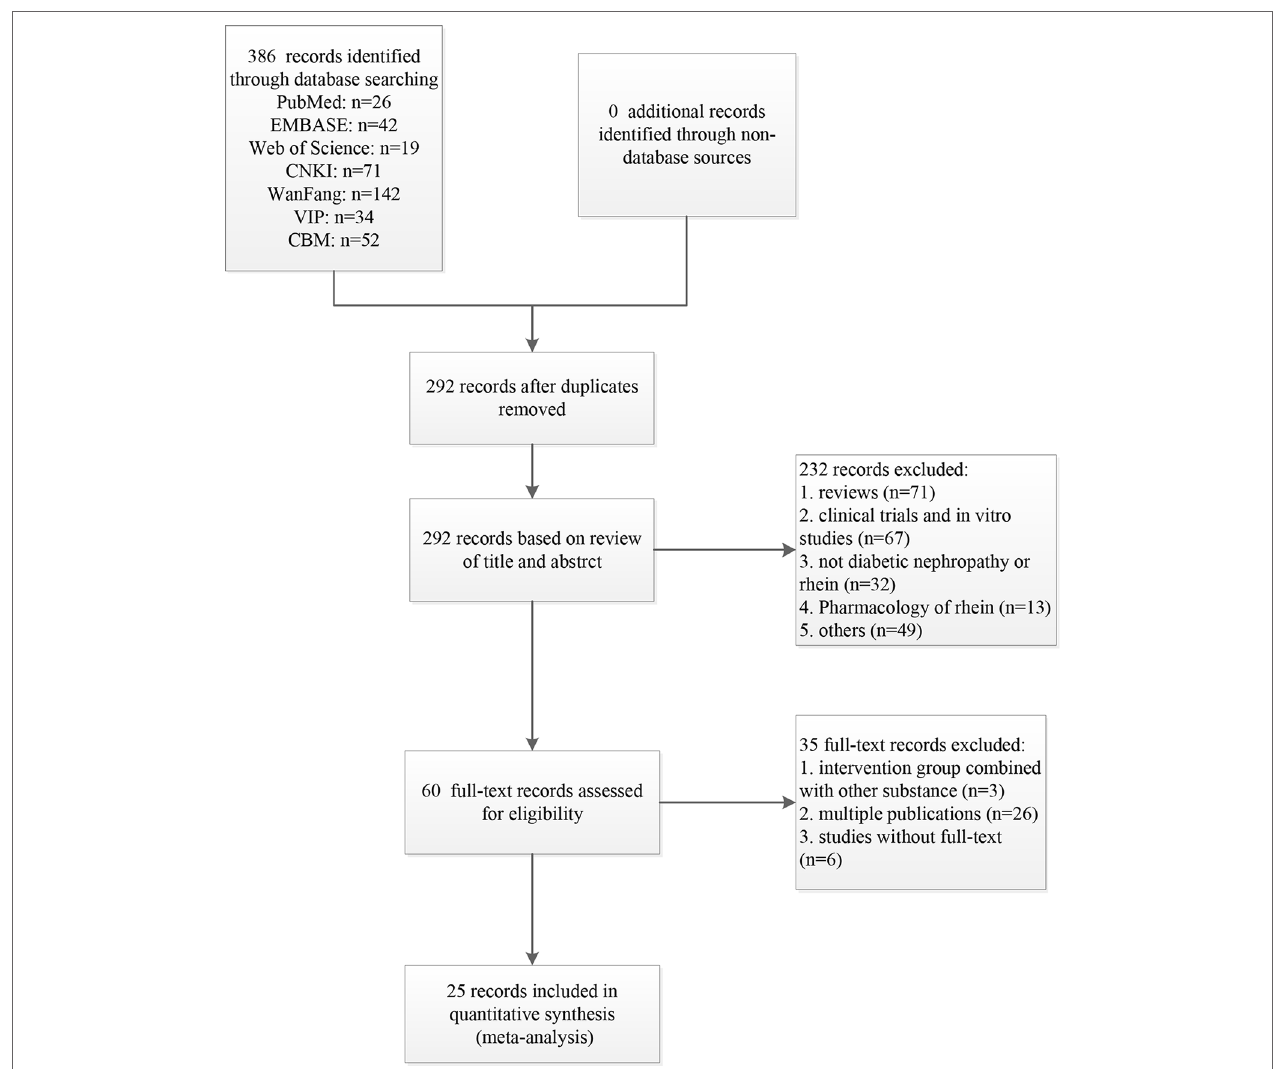
FiGURe 1 | Flow diagram of the study selection process for this systematic review and